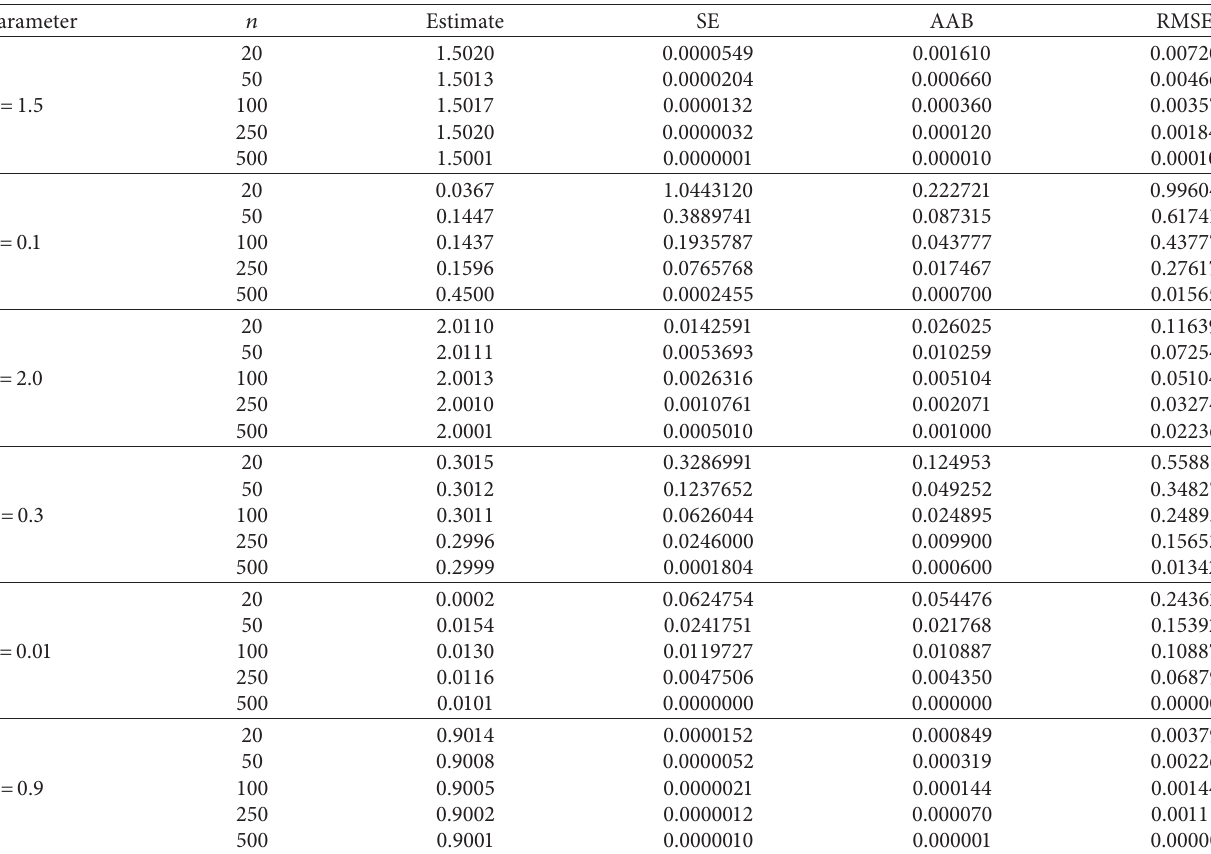
Table 1: Simulation results of